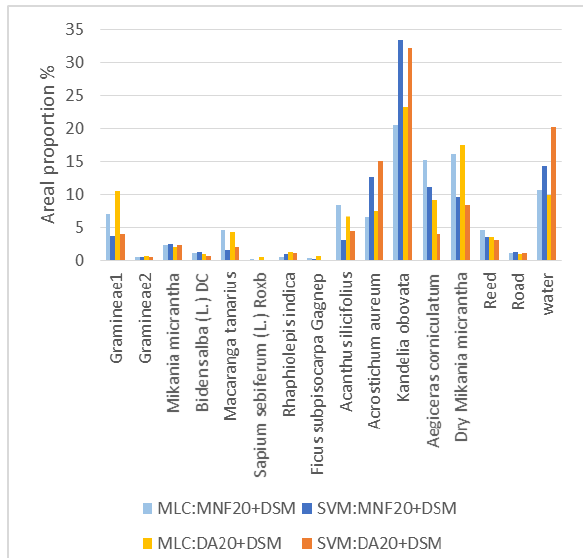
Figure 4. Areal proportion of 16 classes based on classification result